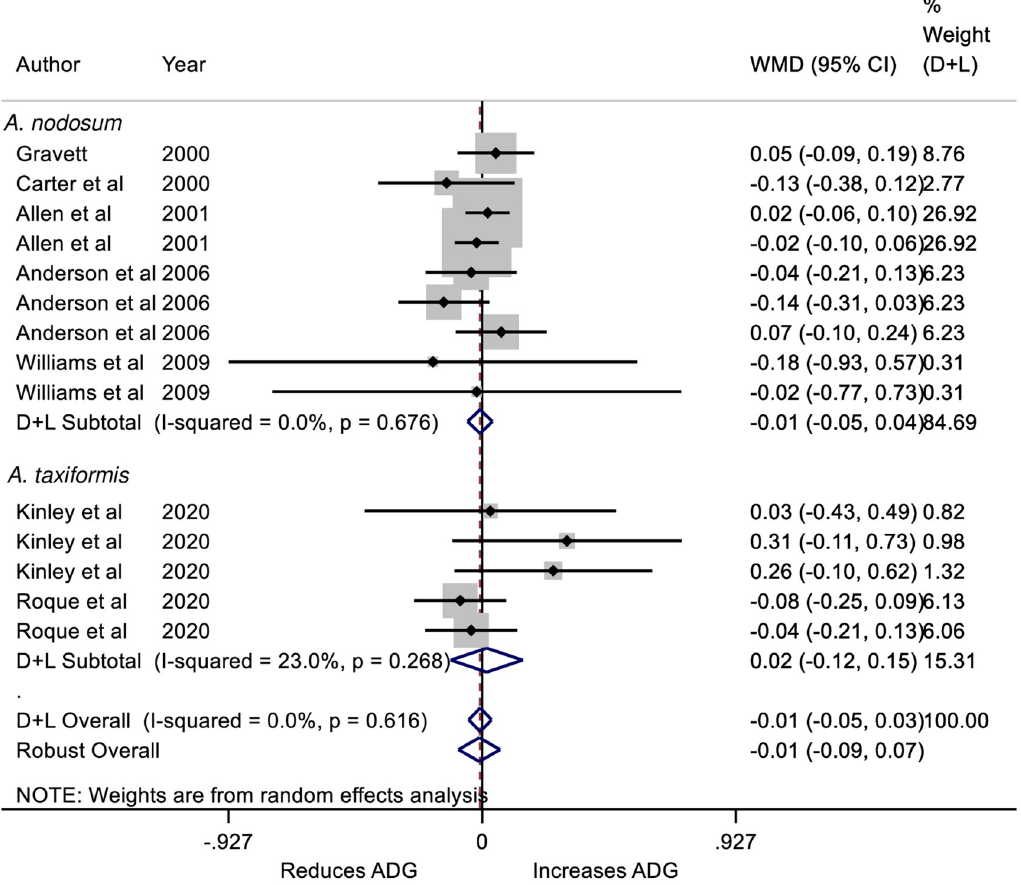
Fig 2. Forest plot of the Weighted Mean Difference (WMD) and 95% CI of the effect of Ascophyllum nodosum and Asparagopsis taxiformis seaweed intervention on the average daily gain (ADG; kg/d) of cattle. The solid vertical line represents a mean difference of zero or no effect. Points to the left of the line represent a reduction in ADG, while points to the right of the line indicate an increase. Each square around the point effect represents the mean effect size for that comparison and reflects the relative weighting of the comparison to the overall effect size estimate. The larger the box, the greater the comparison contribution to the overall WMD estimate. The weights that each comparison contributed are in the right-hand column. The upper and lower limit of the line connected to the square represents the upper and lower 95% CI for the WMD. The overall pooled WMD and 95% CI pooled using the DerSimonian and Laird (D+L) [23] and robust meta-analytical random effects models [18, 26] are indicated by the respective diamonds at the bottom. The heterogeneity measure, I 2 is a measure of residual variation among comparisons included in the meta-analysis. The ADG was not heterogeneous as indicated by the overall I 2 of 0%.